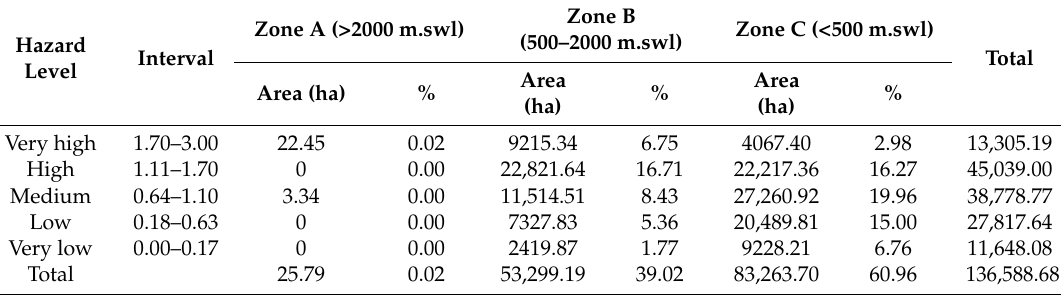
Figure 12. Hazard map of landslides using trigger parameters. Table 5. Results with respect to areas and percentages at each hazard level.